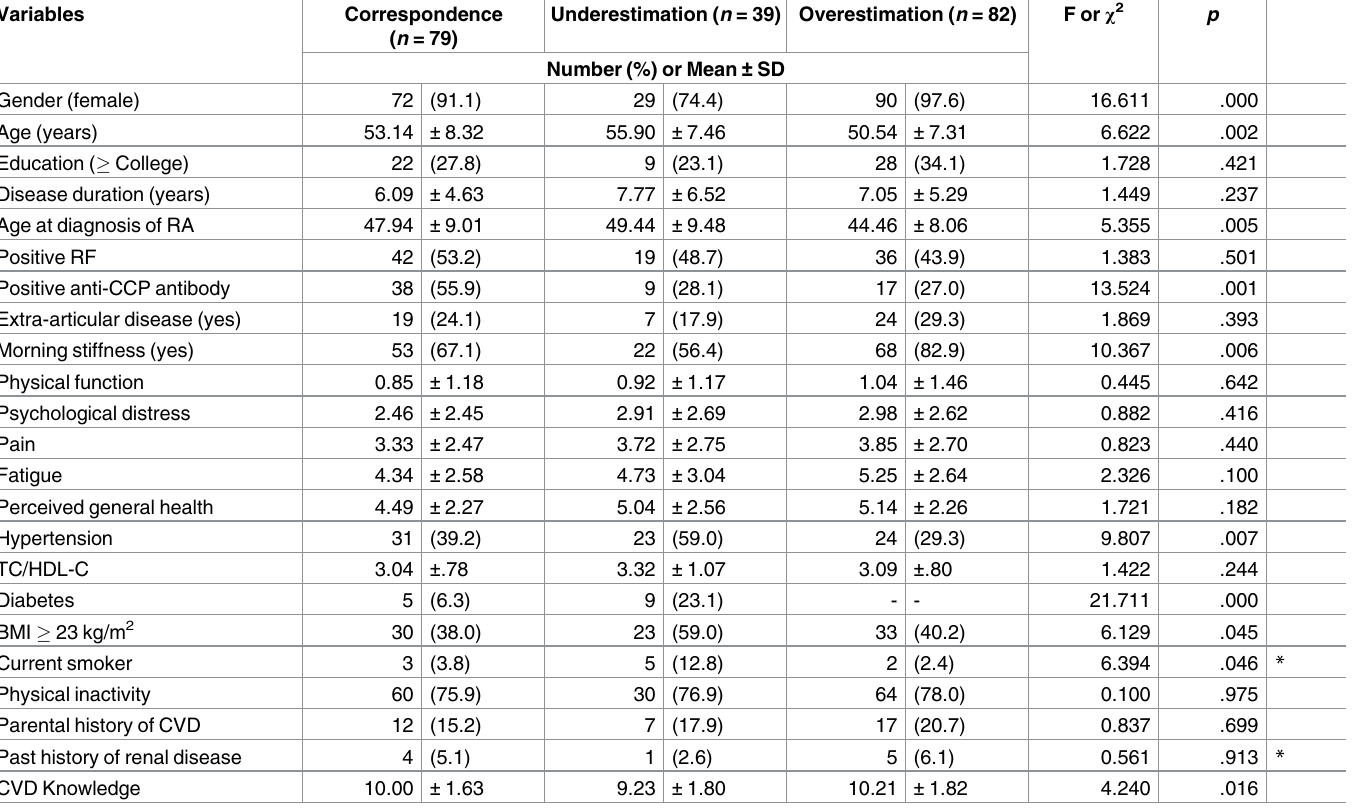
Table 4. Characteristics of participants by level of agreementbetween perceivedand actual CVD risk ( n =